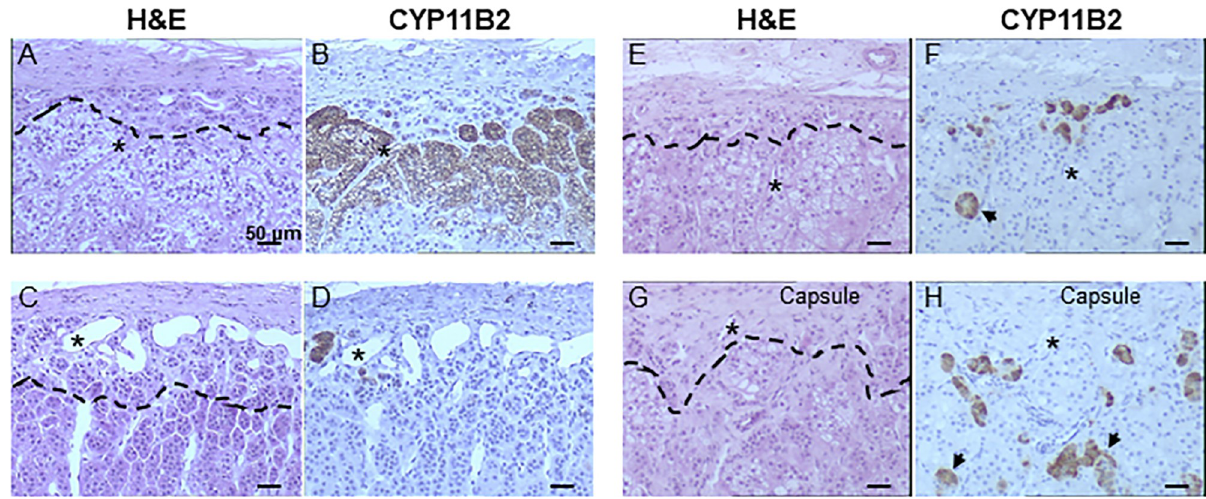
Fig 1. Comparison of histological and functional ZG. H&E staining and CYP11B2 immunolabelling (brown) of consecutive adrenal sections reveal a weak degree of superimposition of histological and functional ZG. (cid:2) indicates CYP11B2 cell clusters migrating into the zona fasciculata. - - - delineates the histological boundary between zona glomerulosa (above) and zona fasciculata (below). (A-D) 22-year-old man. (E-H) 66-year-old man. The sections are matched in consecutive pairs, such as A-B and C-D for the 22-year-old and, E-F and G-H for the 66-year-old adrenal. � identifies common structures on consecutive sections.